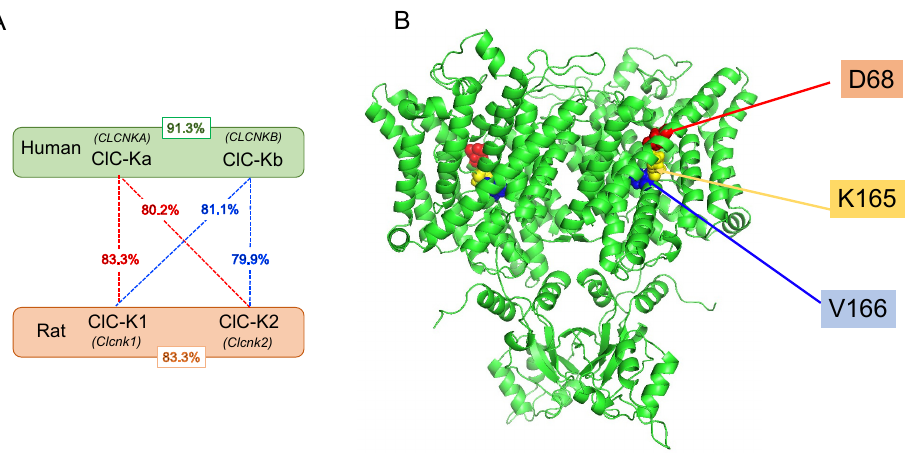
Figure 3. Structure and sequence homology of ClC-K channels. ( A ) The picture shows the sequence homology within ClC-Ks channels in the human and the rat orthologue. ( B ) Three-dimensional representation of ClC-Kb modeled upon cryo-electron microscopy structure of the bovin ClC-K (PDB id: 5TQQ; [8]) showing the localization of the most important residues for ClC-K channels: V166 (blue spheres), D68 (red spheres) and K165 (yellow spheres).